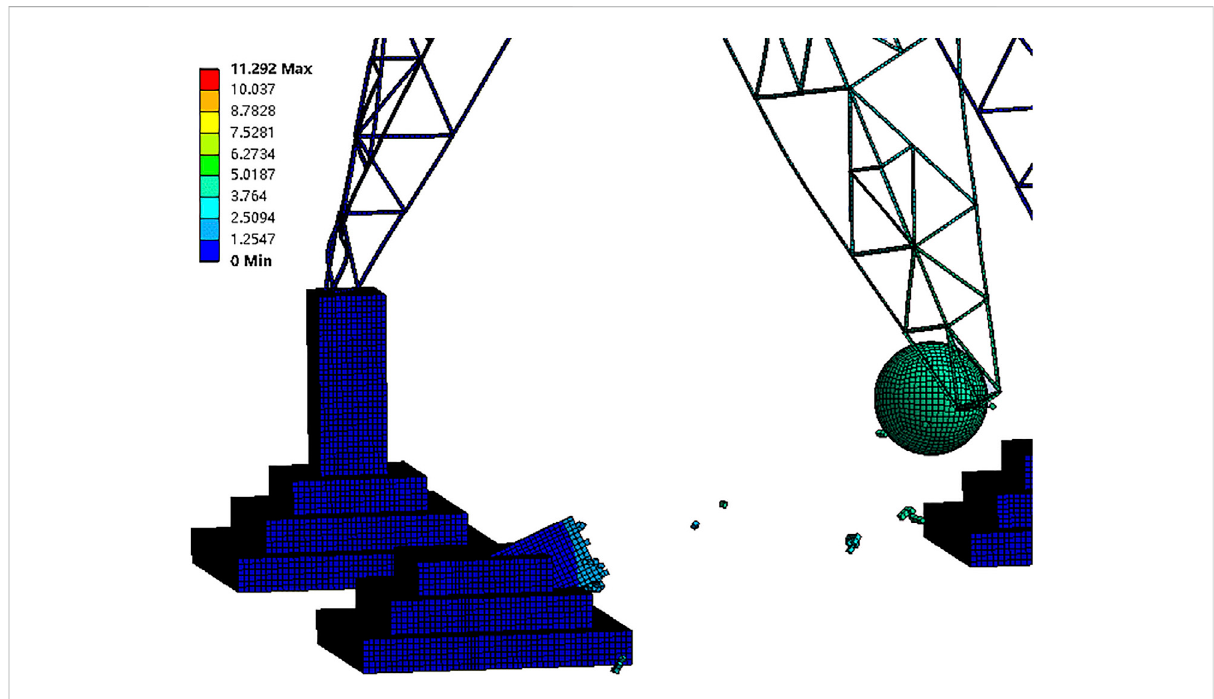
FIGURE 9 Deformation cloud chart under working condition